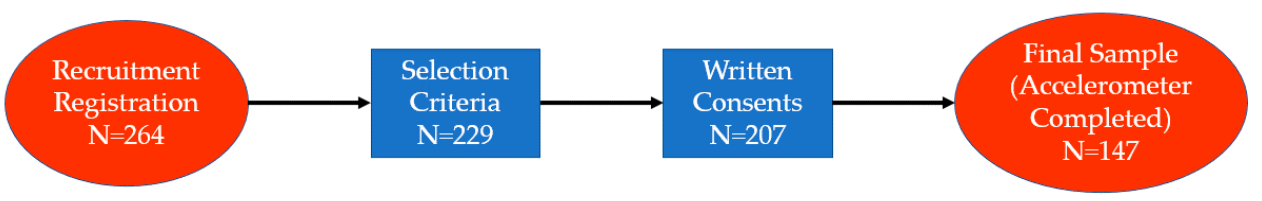
Figure 1. Flow diagram of the sample recruitment.